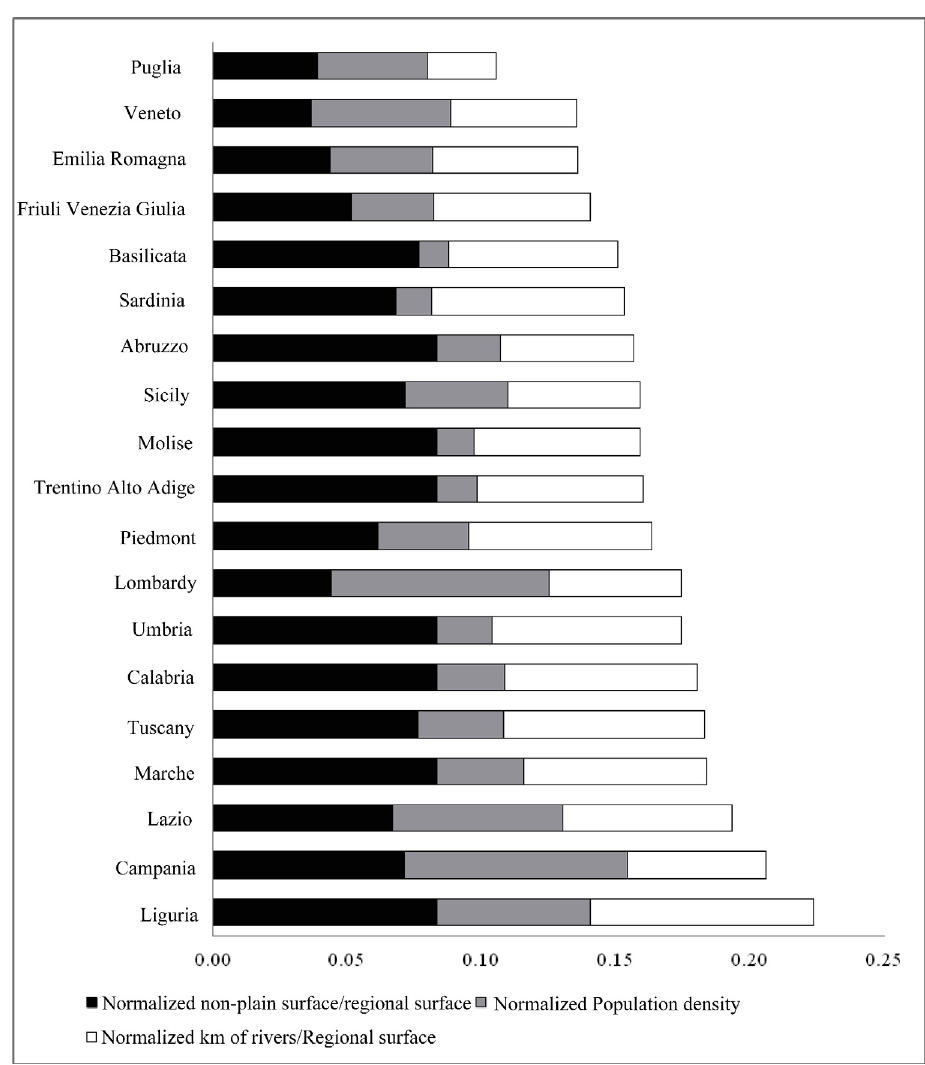
Fig 3. Incidence of normalized features for each Italian